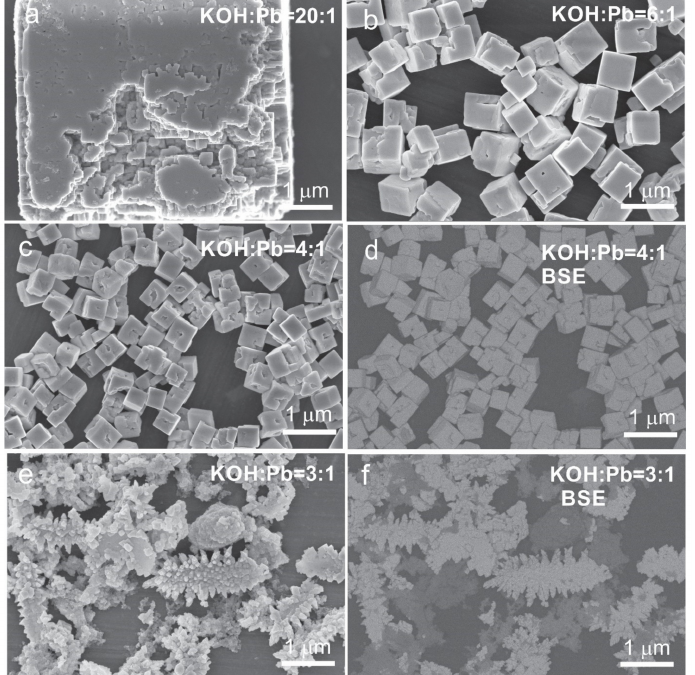
Figure 3. SEM micrographs ( a – f ) of the PZT06 reaction product obtained through one-step precipi- tation process and hydrothermal reaction at 235 ◦ C (12 h) at ( a ) KOH:Pb = 20:1, ( b ) KOH:Pb = 6:1, ( c , d ) KOH:Pb = 4:1, and ( e , f ) KOH:Pb = 3:1: ( a – c , e ) ⇒ SE images; ( d ) and ( f ) ⇒ BSE images of the samples shown in the SE images in ( c ) and ( e ),